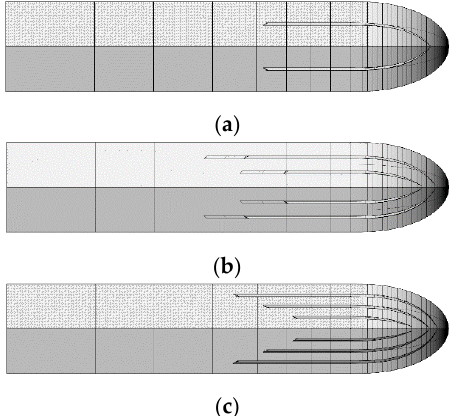
Figure 3. Configuration parameters of conventional profiles: ( a ) 1 strip; ( b ) 2 strips; ( c ) 3 strips.